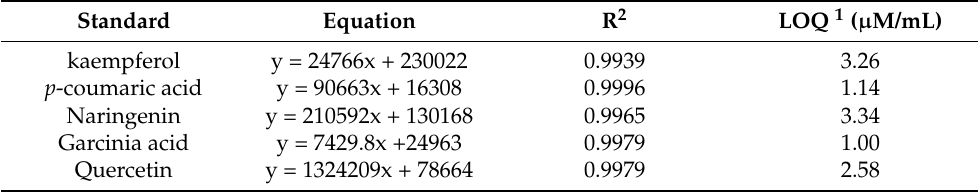
Table A1. Analytical parameters of the method of quantification of bioactive